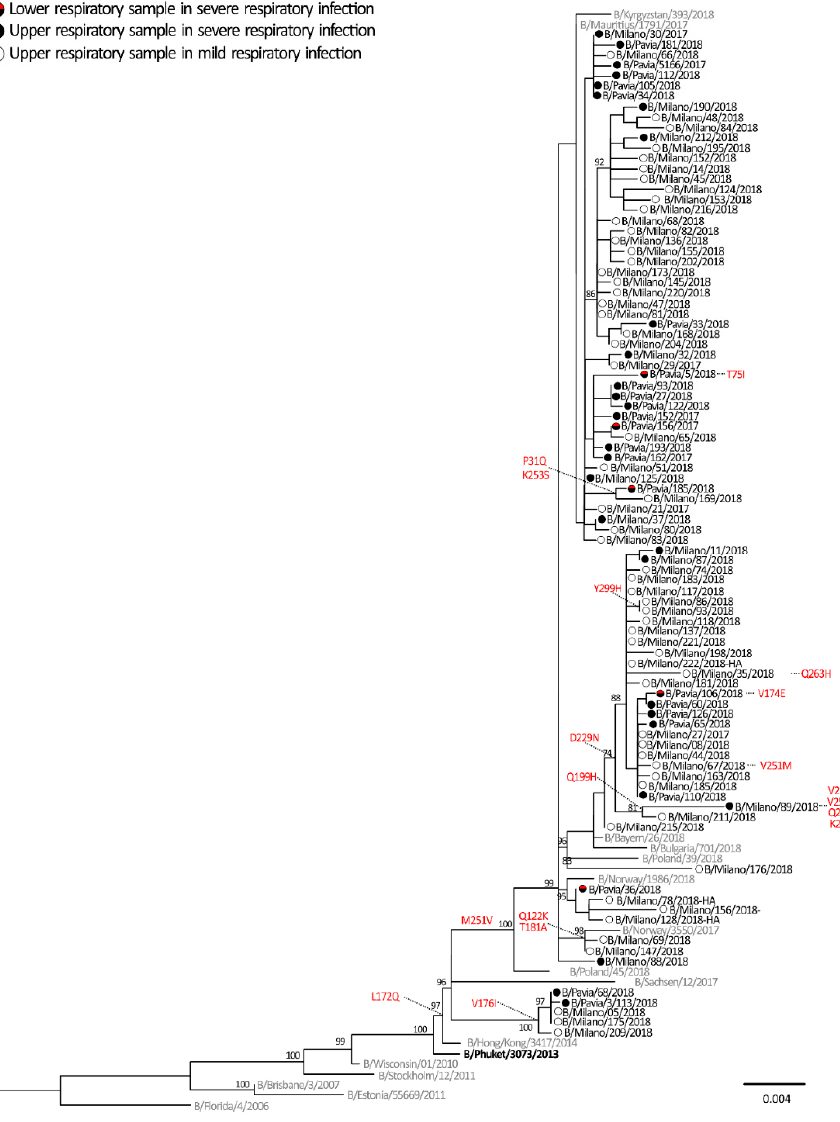
Figure 3. Phylogenetic tree of HA sequences of B viruses which was inferred by using the maximum likelihood. The percentage of replicate trees in which the associated taxa clustered together in the bootstrap test (1000 replicates) is shown next to the branches. Influenza B sequences originally identified in this study are reported with black circles (URT sample of severe case), red / black circles (LRT samples of severe cases) and white circles (URT samples of mild cases). The vaccine strain is reported in bold and reference strains are reported in grey. Amino acid mutations are reported in red.